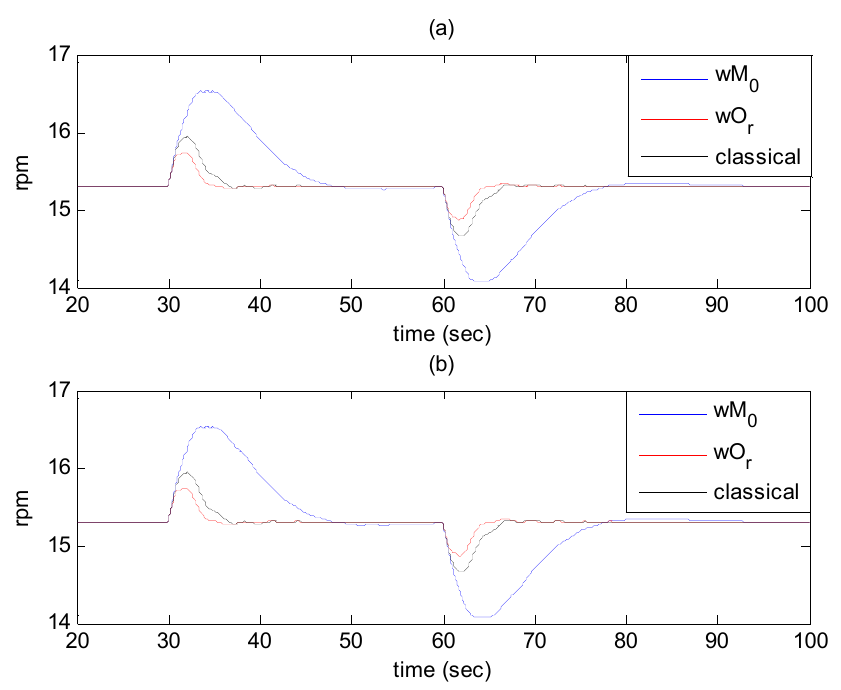
Figure 6. Responses of rotor speed (more weighting on blade moment(blue), more weighting on rotor speed(red), PI-based control(black)): ( a ) without IPC; ( b ) with